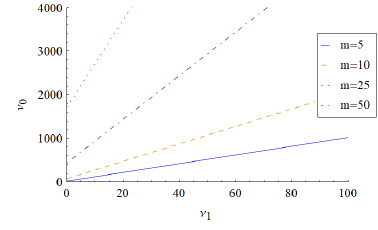
Figure 11. Boundary lines for comparison of T 2 and T 7 .